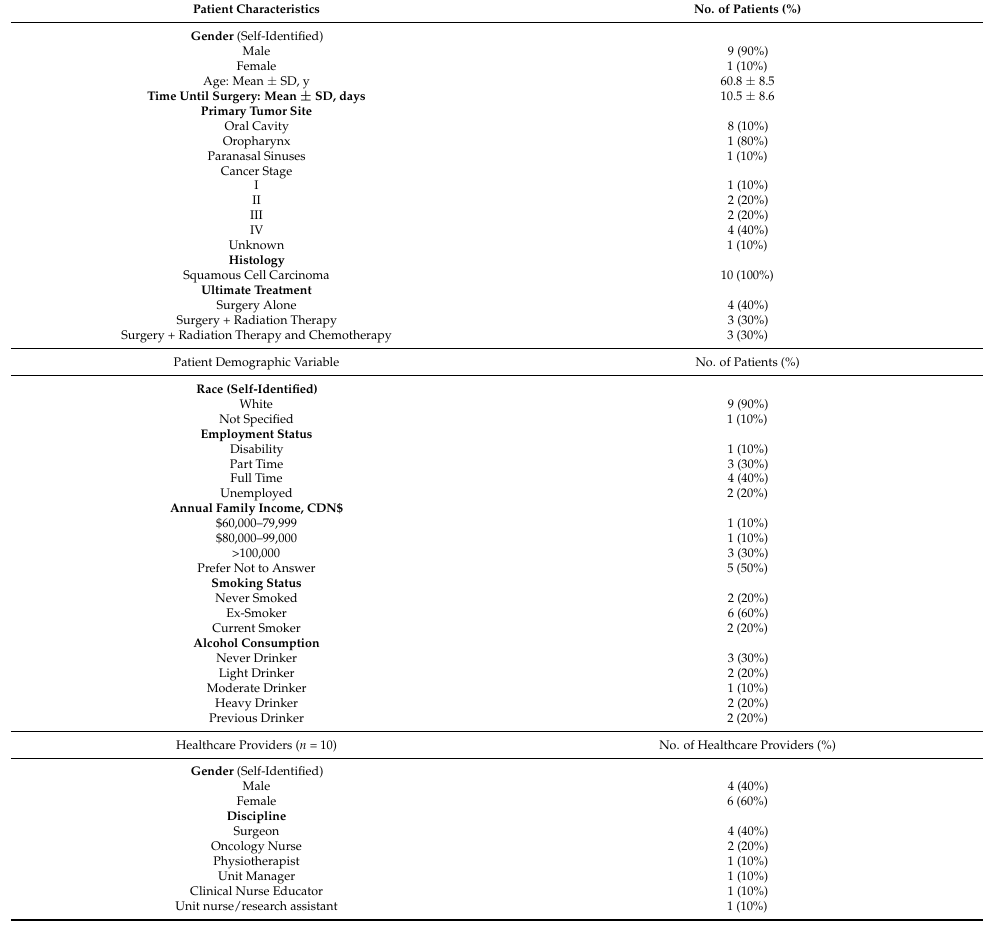
Table 1. Baseline characteristics of participants: patients, n = 10 and healthcare providers, n =